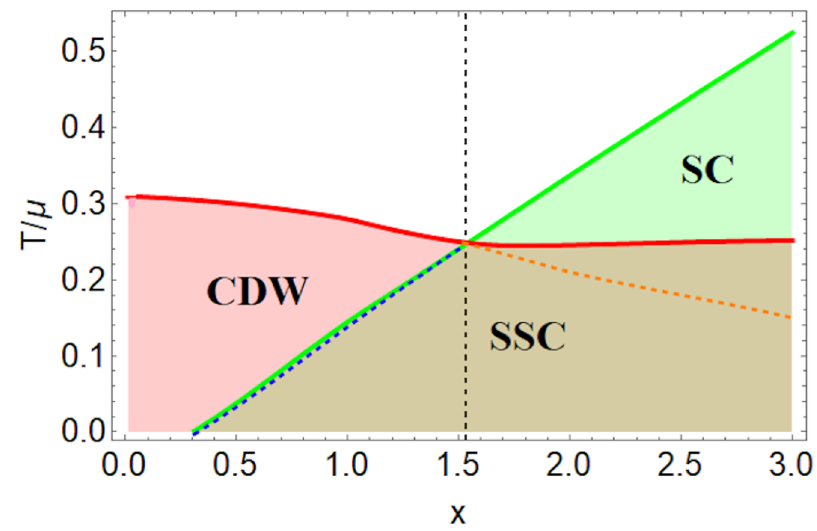
Figure 9 . The phase diagram in ( x , T ) plane. The dashed vertical line corresponds to x c ≈ 1 . 53 . CDW order, uniform SC order and PDW order, where x parameter. The dashed curve in orange depicts the critical temperature T in the absence of SC phase, while the curve in red depicts T